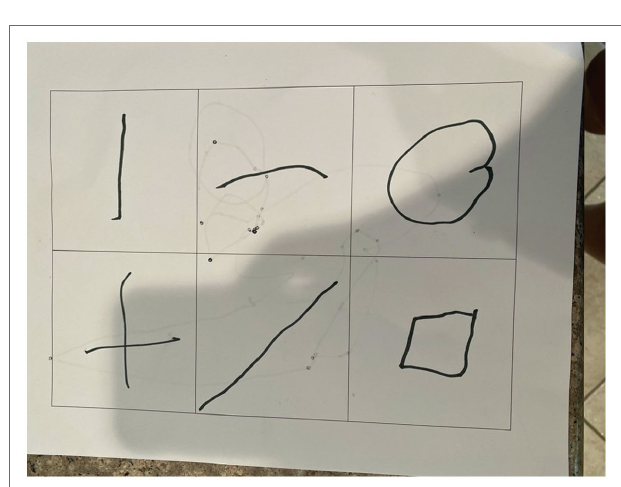
FIGURE 4 | Example images from the modified Beery DTVMI